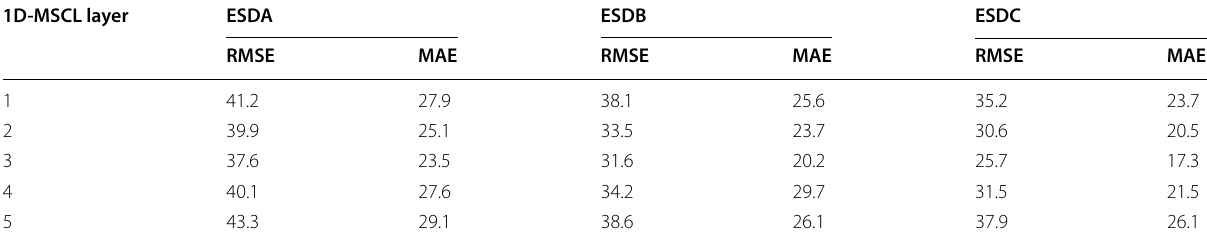
Table 5 Analysis on 1D-MSCL layer 1D‑MSCL layer